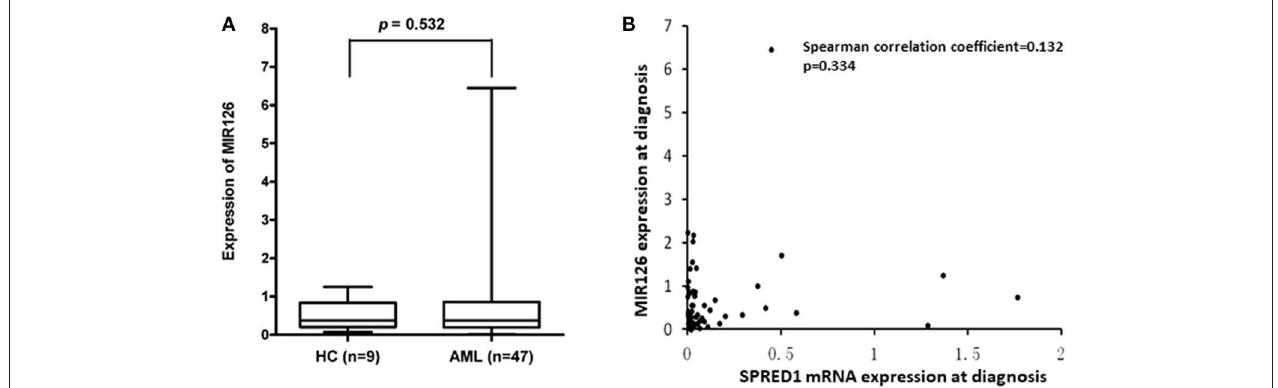
FIGURE 6 | Correlation between SPRED1 and MIR126 mRNA expression level at diagnosis. (A) Comparison on MIR126 expression in HC and AML (Wilcoxon tests); (B) spearman correlation analysis between SPRED1 mRNA expression MIR126 expression.